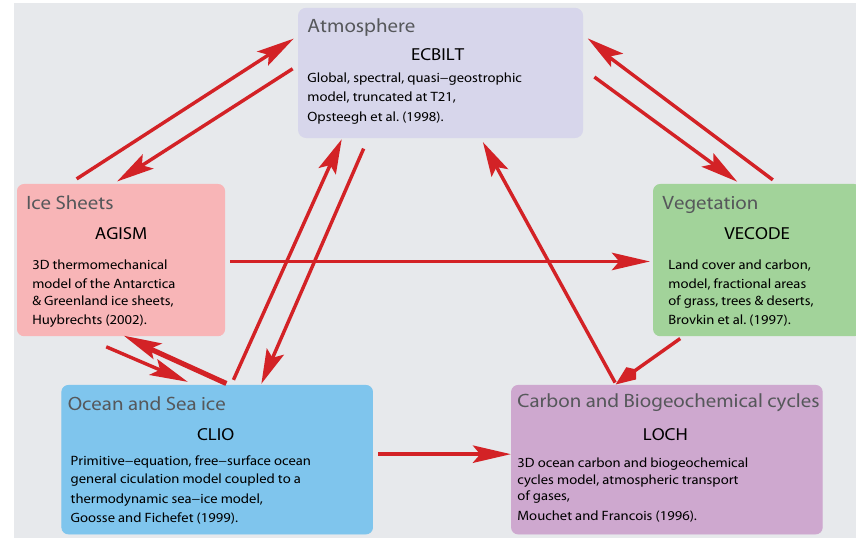
Fig. 1. Sketch of the LOVECLIM model showing the interactions between the five components.